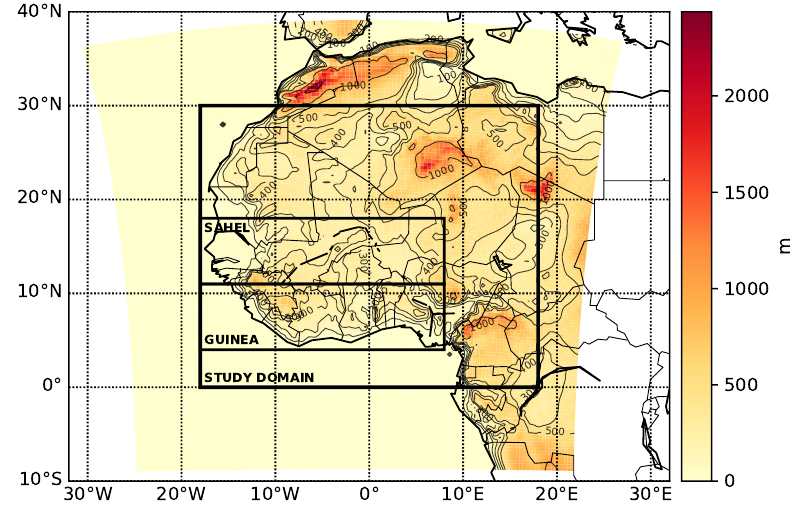
Figure 1. MAR integration domain and model topography (shading), the West Afica study domain, Guinea and Sahel